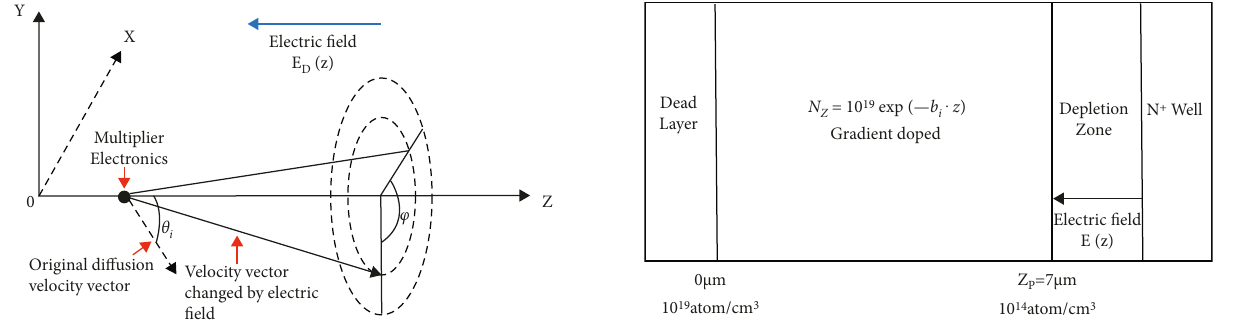
Figure 4: Changes in the trajectory of electron motion under the action of gradient electric field.